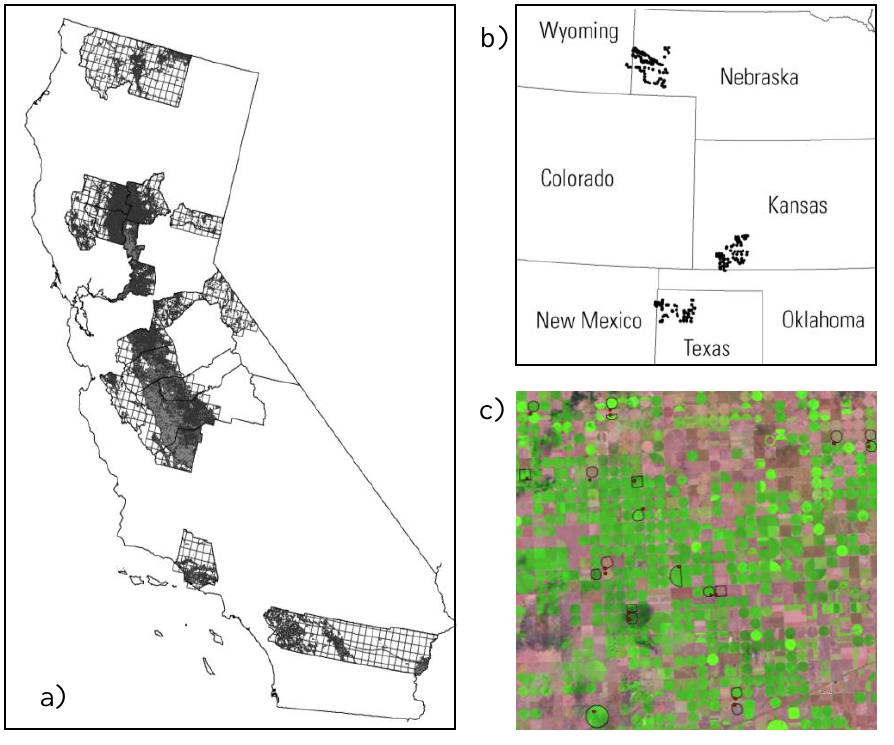
Figure 6. Showing the spatial distribution of irrigation ground truth data used in the accuracy assessment, (a) California Department of Water Resources field boundaries for 19 counties surveyed between 2000 and 2004, gray shaded fields were irrigated and void outlined fields were non-irrigated, (b) black dots were the ground truth points surveyed by University of North Dakota during July–August 2006, and (c) a polygon was drawn for each of the ground truth points by overlying them on August 2006 Landsat images and using the point attributes taken during the survey, these polygon areas were used in the accuracy assessment instead of the points